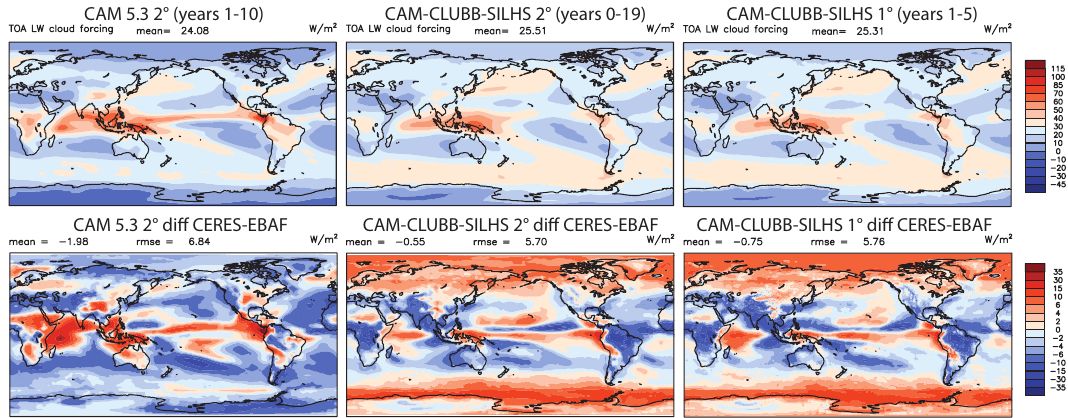
Figure 4. Top-of-the-atmosphere long-wave cloud forcing (LWCF) for CAM 5.3 (left), CAM-CLUBB–SILHS 2 ◦ (center), and CAM- CLUBB–SILHS 1 ◦ (right). The difference from Clouds and Earth’s Radiant Energy Systems (CERES) energy balanced and filled (EBAF) observations of LWCF (model − obs) is shown in the second row. CAM-CLUBB–SILHS has a slightly lower global error in LWCF